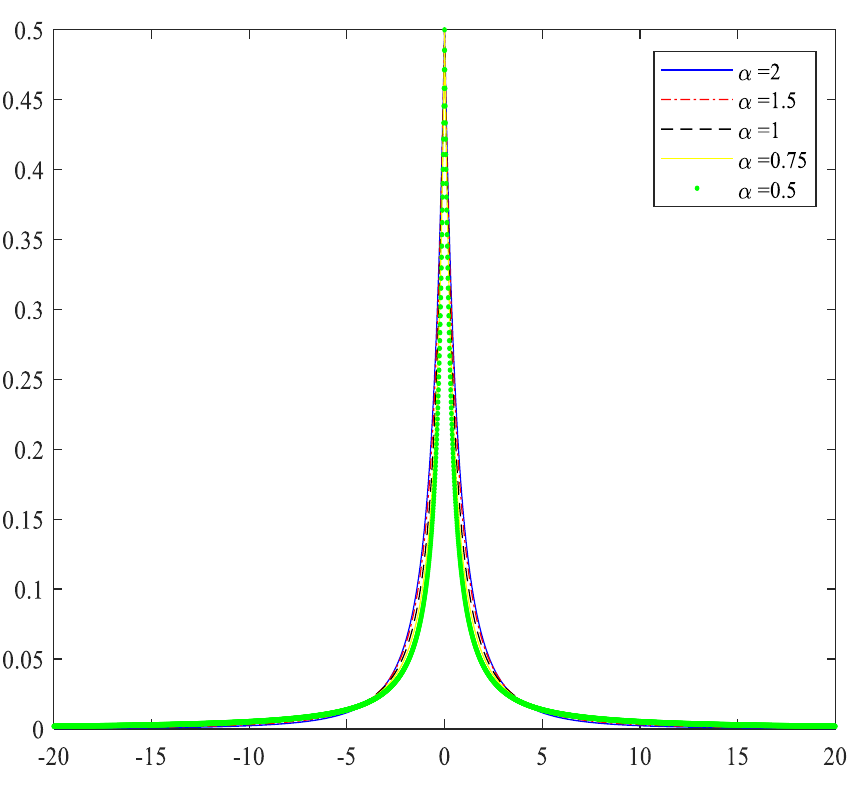
Figure 6. Comparison of δ value in GPD PDF plots.